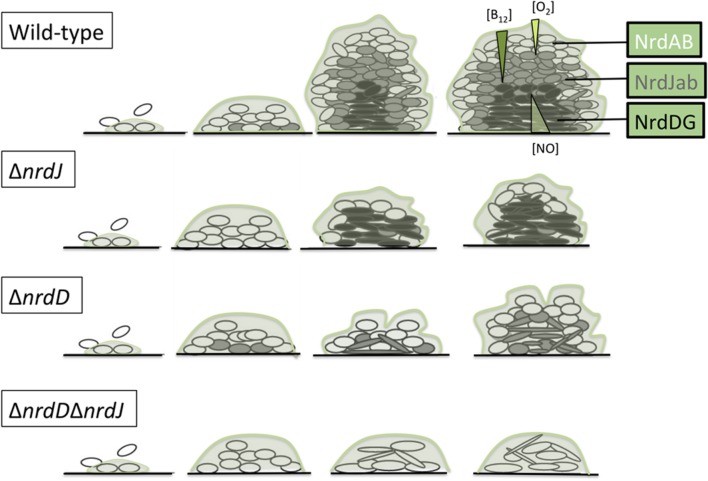
Model of ribonucleotide reductases expression during P. aeruginosa biofilm formation. Oxygen concentration is progressively reduced throughout the biofilm structure in a well-established gradient (Xu et al., 1998; Stewart and Franklin, 2008). Vitamin B12 and NO gradient concentrations also presented here are hypothetical (see the Discussion section).